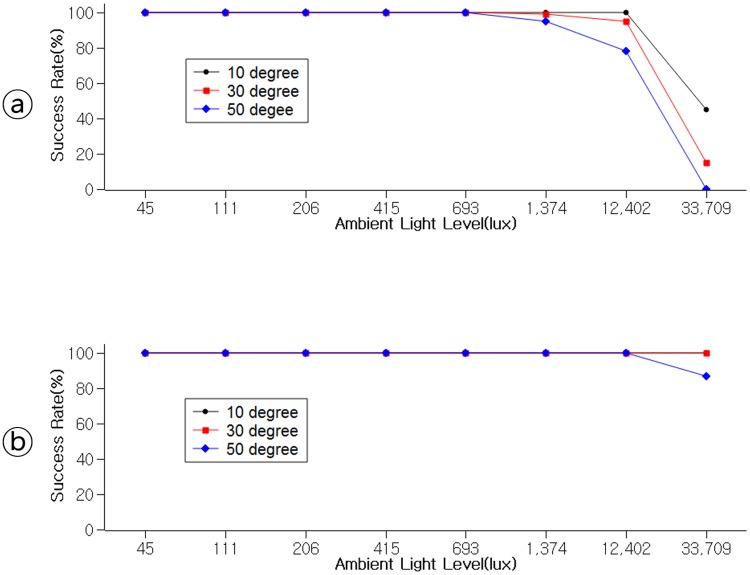
Device binding success rate under varied ambient light intensity with ⓐ: 63cd/m2 display; ⓑ: 143cd/m2 display.